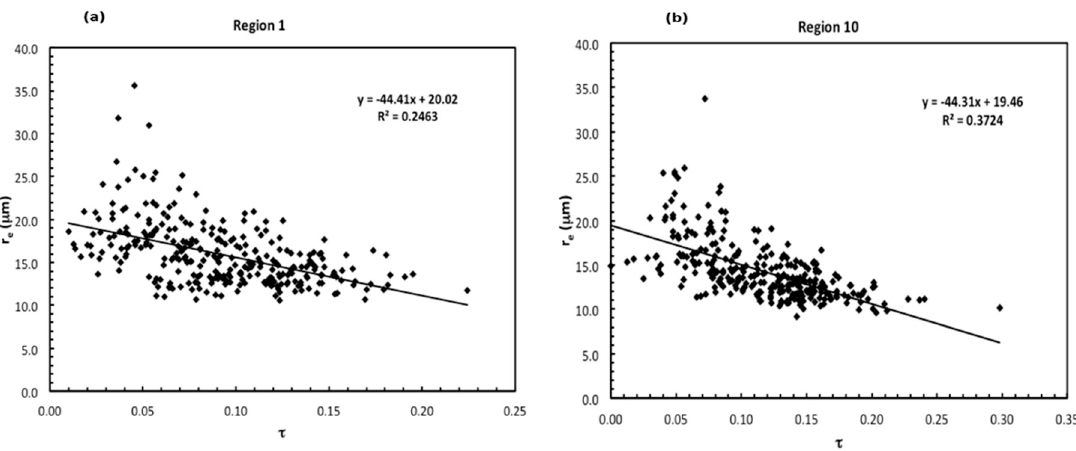
Figure 13. Scatter plot of AOT vs. CDER for the monthly mean data averaged for ( a ) Region 1 (offshore of California) and ( b ) Region 10 (offshore of Southwest Europe) over the time period from 1981 to 2011. The straight line is the linear regression line and its formula is also provided along with the square value of the correlation coefficient ( R 2 ).